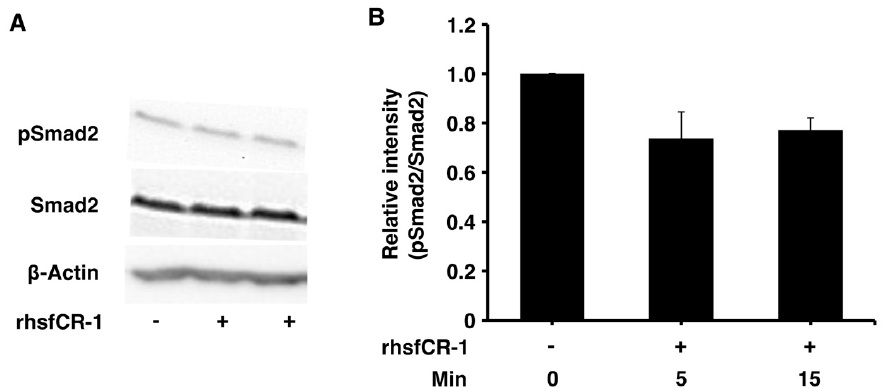
Figure 4. rhsfCR-1 inhibited Smad2 phosphorylation in miPS-LLCcm cells. ( A ) Phosphorylation of Smad2 in miPS-LLCcm cells was assessed by Western Blotting treated with 1 µg/mL rhsfCR-1 for 5 and 15 min in the absence serum. Beta-actin was used as a control. The representative blot was shown; ( B ) the relative intensity of Smad2 phosphorylation bands normalized by each band of Smad2 in Western Blots from three different experiments was densitometrically analyzed using ImageJ software.